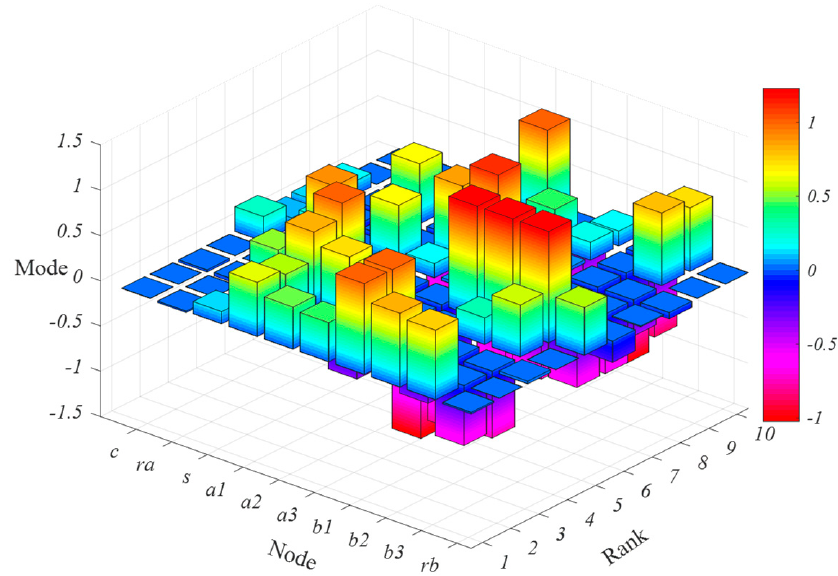
Figure 6. The vibration modes of each order of the composite planetary gear system.